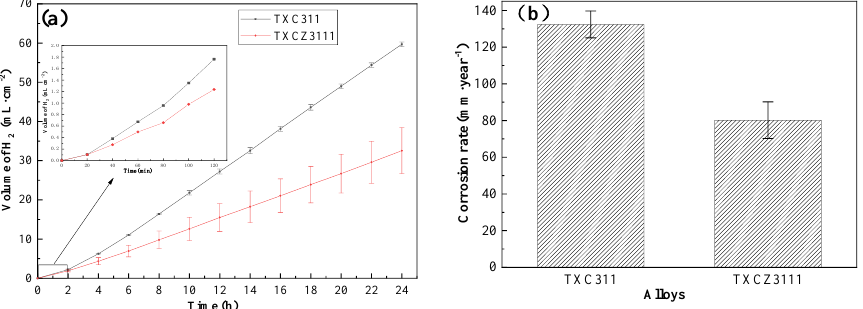
Figure 5. Corrosion of homogenized TXC311 and TXCZ3111 alloys by immersion for 24 h. ( a ) Volume of H 2 ; ( b ) corrosion rate